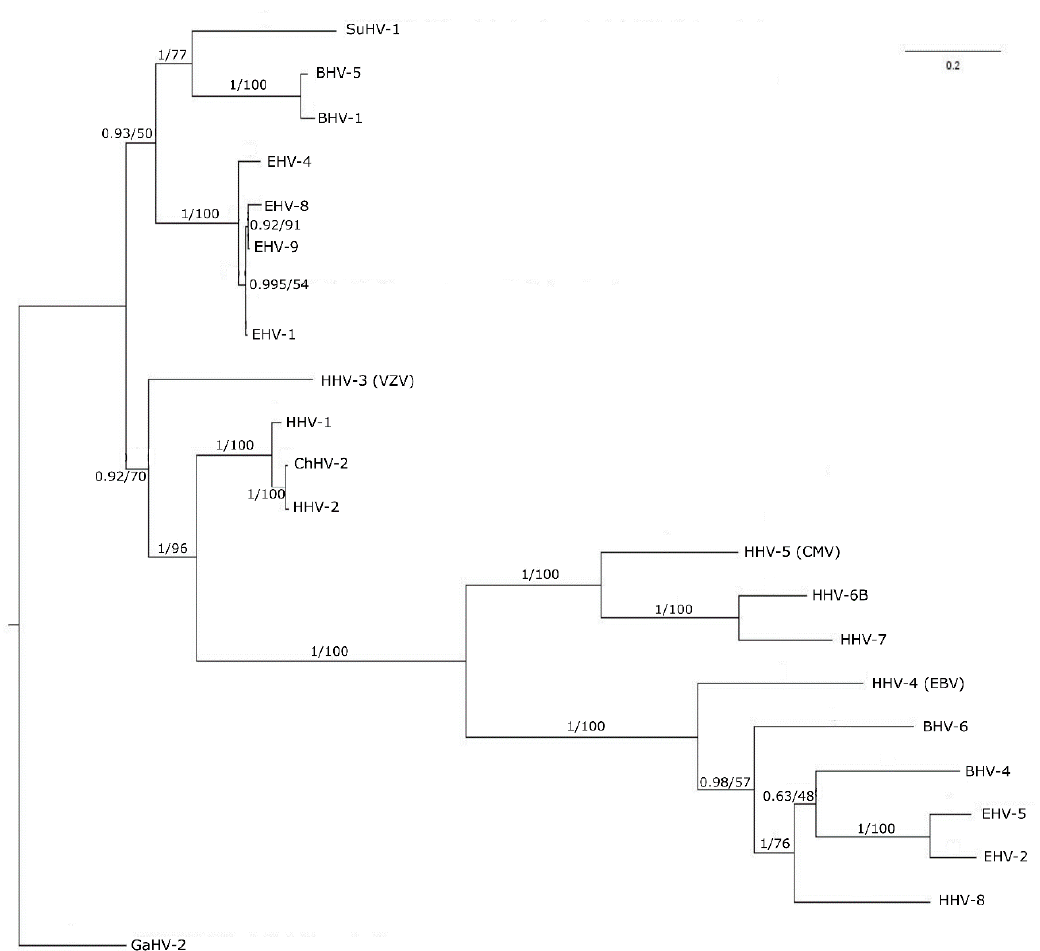
Figure 3. Phylogenetic tree of 21 homologs of HHV-1 pUL15. The tree is rooted on an outgroup GaHV-2. Sequences are labeled by virus abbreviations. Each node shows the posterior probability value from a Bayesian analysis followed by the bootstrap support value reported as percentages from maximum likelihood analysis. The scale bar represents the number of substitutions along each branch.